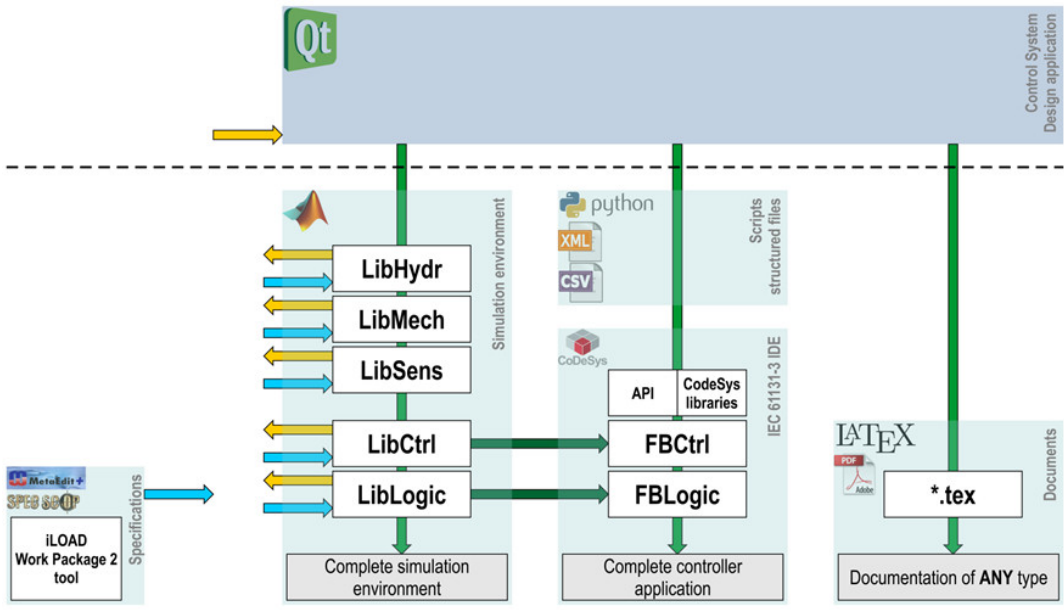
Figure 15. One of the toolchains validated at West Pomeranian University of Technology, Szczecin, within the iLOAD project. Multi-vendor software integration: MetaEdit+, Matlab/Simulink, CodeSys v.3.5, Latex/MikTeX, Qt framework, Python.